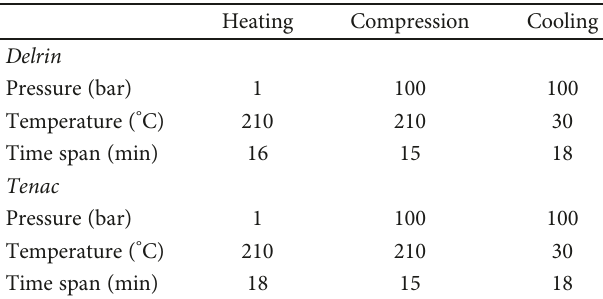
Table 2: Processing parameters used for compression molding (plate dimension: 150 × 150 × 4